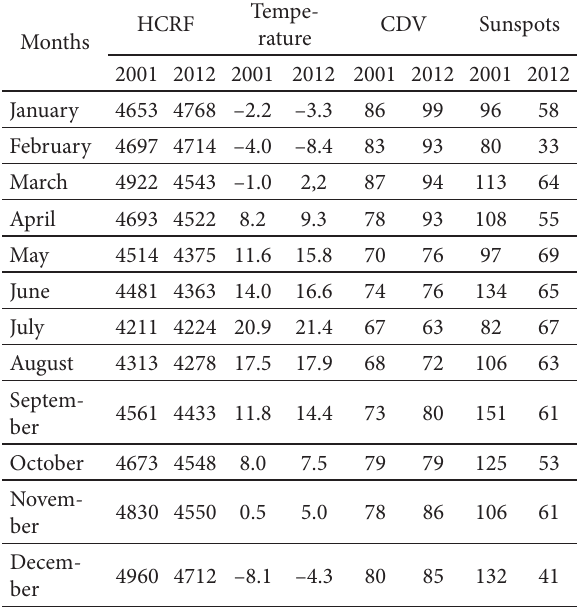
Table 1. Average monthly values of hard cosmic ray flux (HCRF) in imp/h, temperature (ºC), cardiovascular diseases (CVD) in Vilnius and sunspot numbers in 2001 and 2012